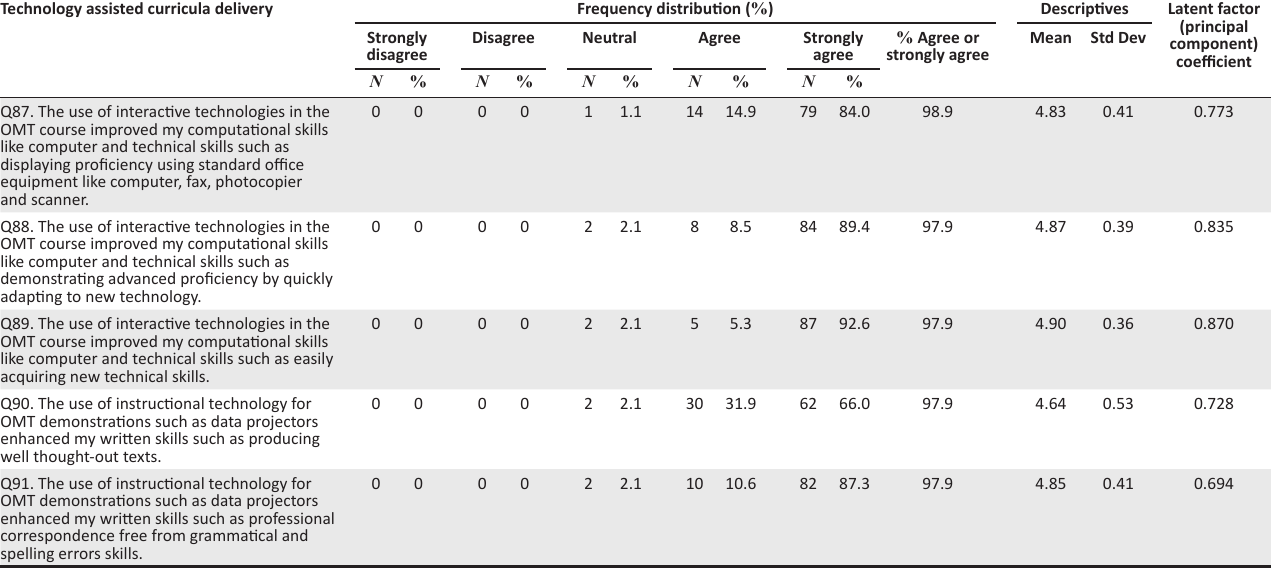
TABLE 13: Influence of technology assisted curricula